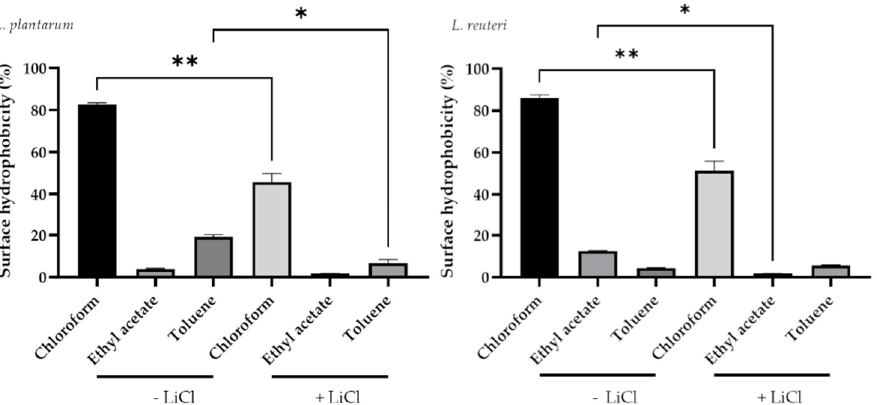
Figure 3. Effect of LiCl treatment on cell surface hydrophobicity of lactobacilli strains. Data are presented as LS means ± SEM. * Indicates a statistically significant difference ( p ≤ 0.05); ** indicates a statistically significant difference ( p ≤ 0.001).